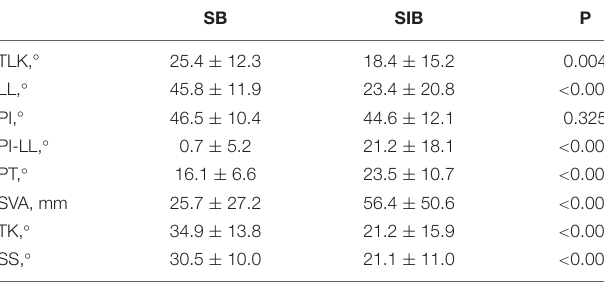
TABLE 2 | Spino-pelvic parameters in matched and unmatched groups.